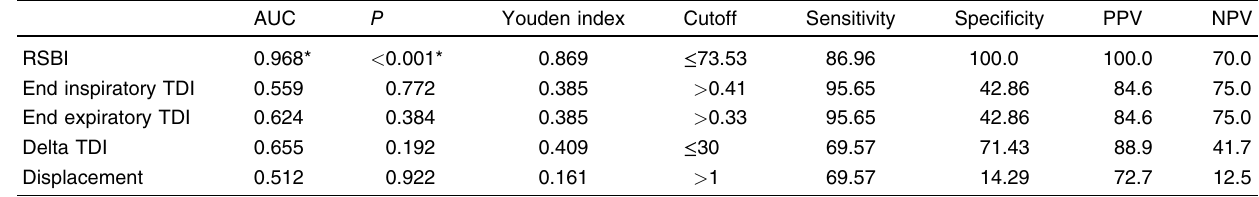
Table 2 Agreement (sensitivity, specificity, and accuracy) for different parameters to predict outcome (success) AUC